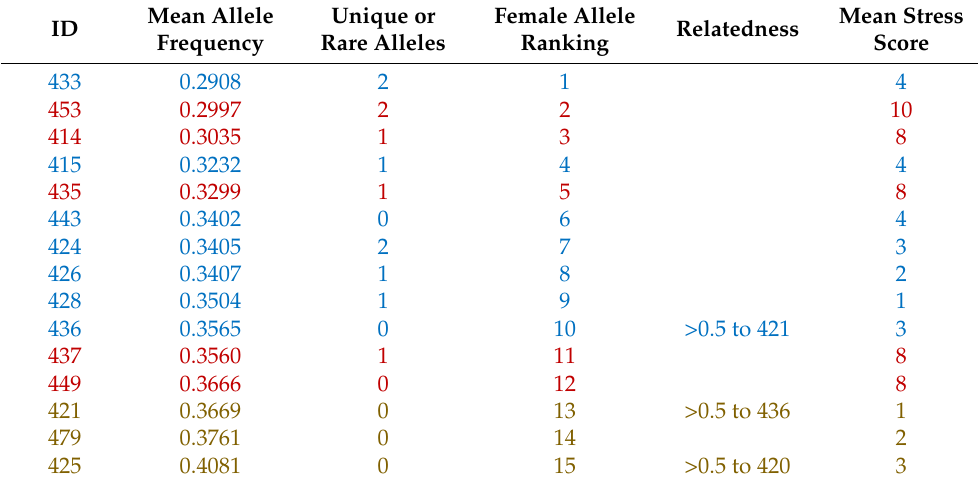
Table 2. Mean allele frequencies, number of unique or rare alleles, MAF rankings from number 1 (most uncommon alleles in their genotype) to 15 (most common alleles in their genotype), relatedness, and stress scores from number 1 (low) to 10 (high) for selection of female founders. IDs in red were proposed as potential founders but not used as founders, gold were used as founders but not proposed as potential founders, and blue were both proposed and used as founders.